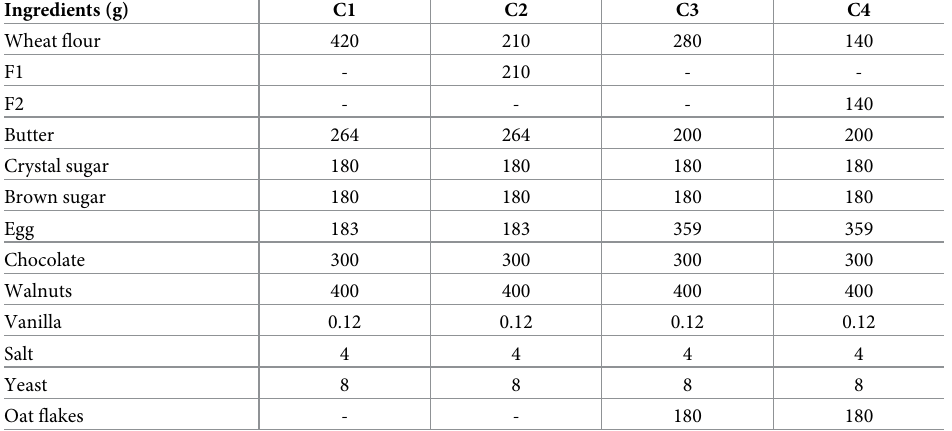
Table 1. Cookies formulations. Ingredients (g)